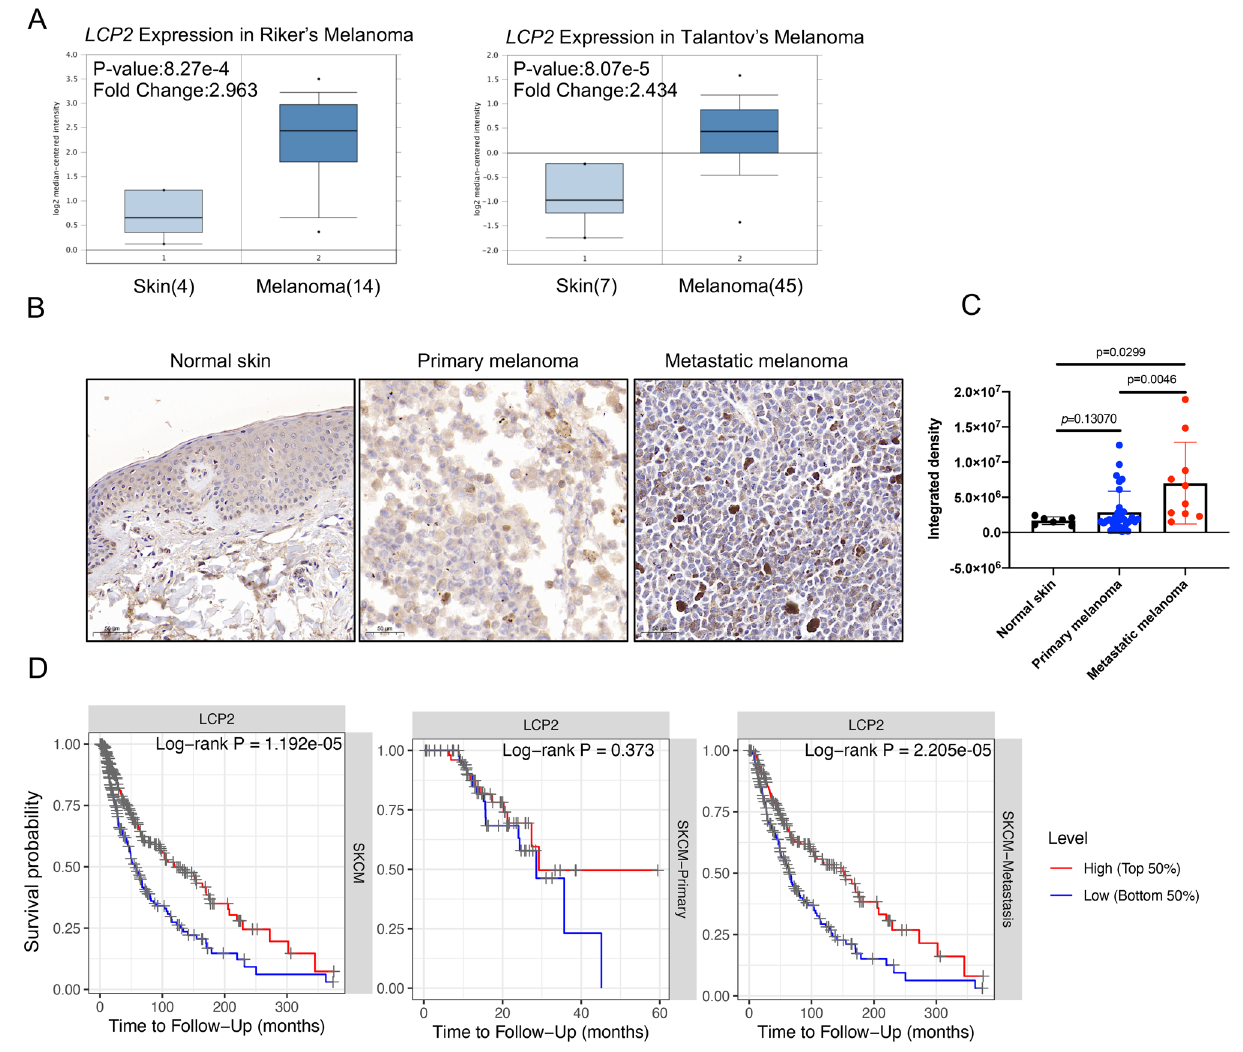
Figure 2. The expression and prognostic value of LCP2 in melanoma. ( A ) LCP2 expression level in human normal skin tissue and skin cutaneous melanoma. Based on the Oncomine database, box-plot diagrams were displayed to compare the LCP2 level in human normal skin tissue with that in skin cutaneous melanoma from studies reported by Riker et al. ( p value: 8.27e−4, Fold Change: 2.963) and Talantov al. ( p value: 8.07e−5, Fold Change: 2.434). ( B ) LCP2 protein expression in normal skin, primary melanoma and metastatic melanoma tissue. ( C ) Quantitative analysis of immunohistochemistry indicated that LCP2 protein was highly expressed in metastatic melanoma tissue compared with normal skin and primary melanoma. ( D ) Based on differential LCP2 expression level, patients with high- LCP2 expression had a better prognosis as compared with those with low- LCP2 expression in skin cutaneous melanoma and in cutaneous melanoma with metastasis, but not in primary sites of skin cutaneous